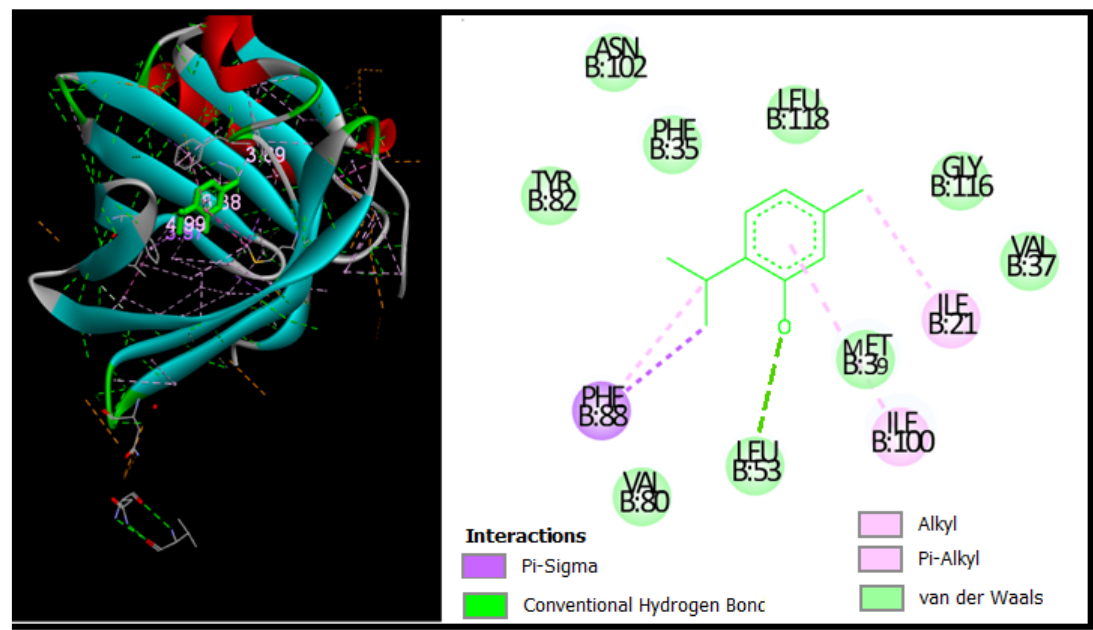
Figure 4. The 2D and 3D docking poses proving thymol interactions in binding sites.